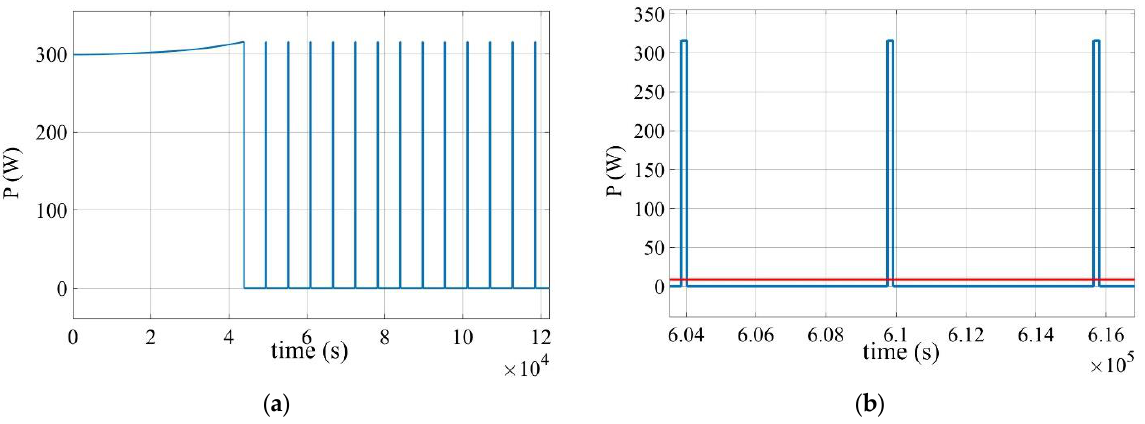
Figure 12. ( a ) Dynamo losses vs. time, ( b ) dynamo losses vs. time enlargement; blue line is the instant dissipated power, red line is average dissipated power.